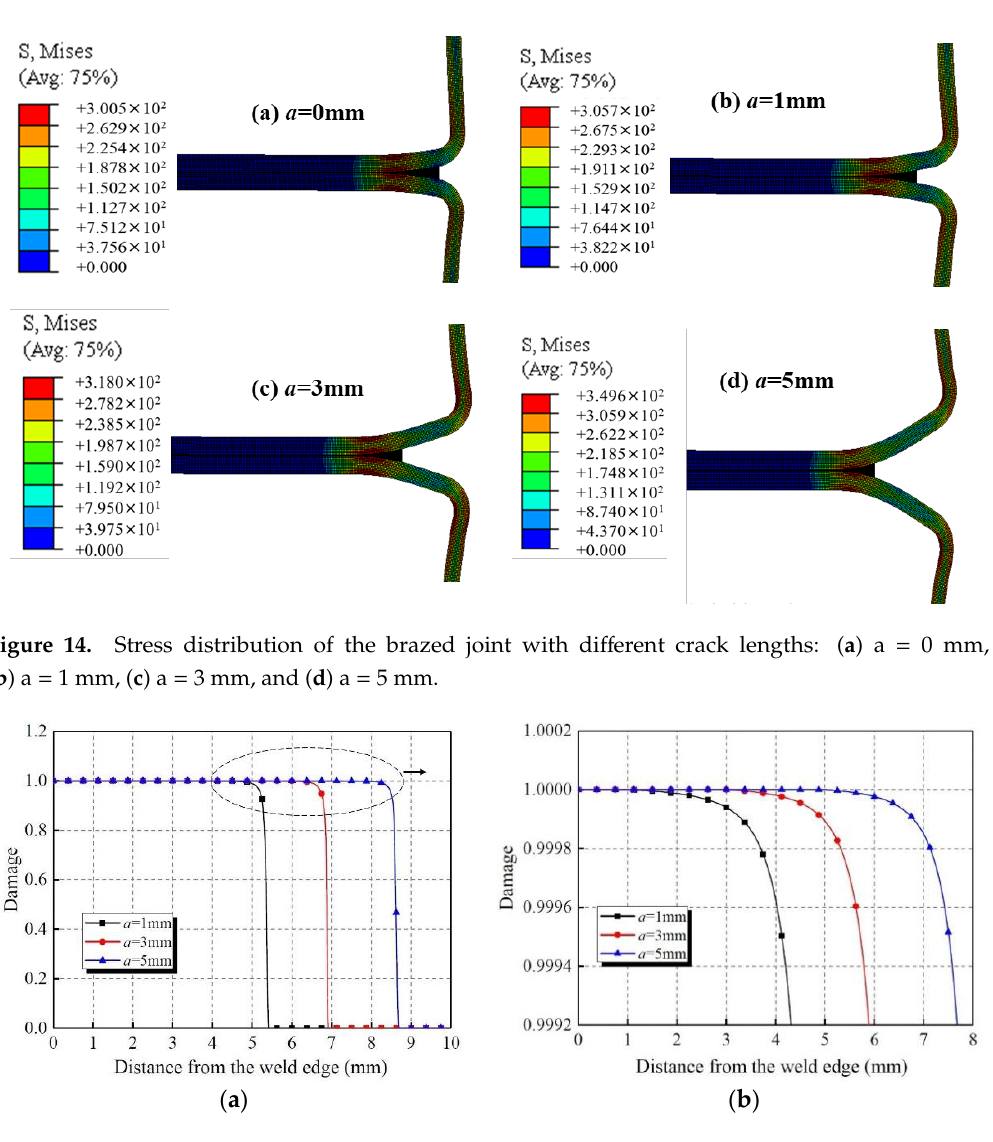
Figure 15. ( a ) Damage distribution of the cohesive element along the weld seam after crack propagation; ( b ) partial enlargement.